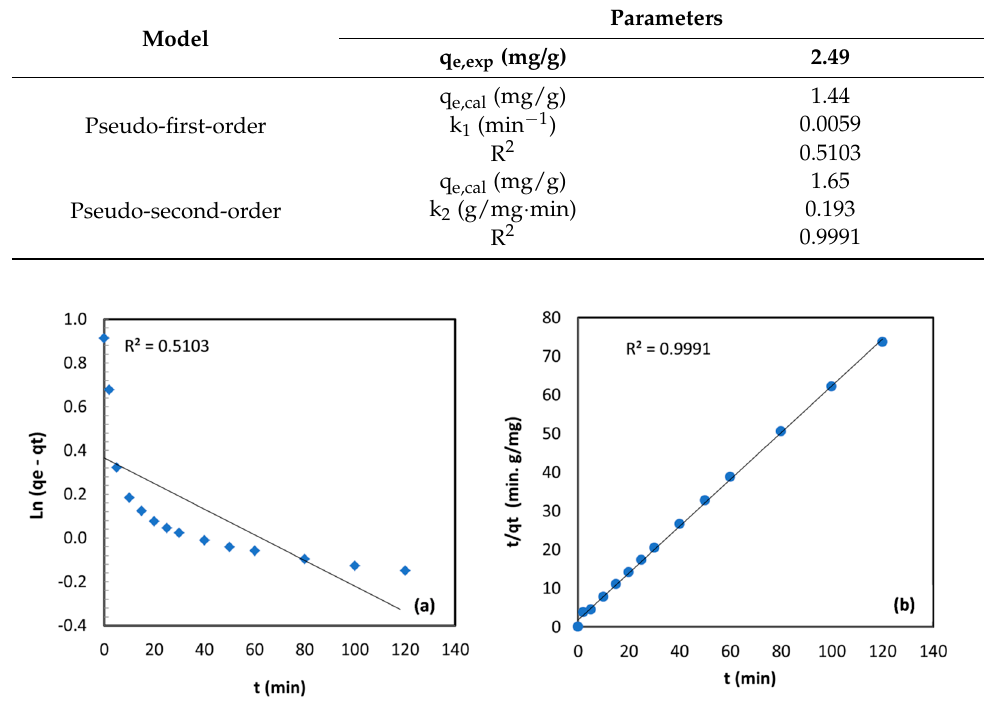
Table 3. Kinetic models constant parameters and correlation coe ffi